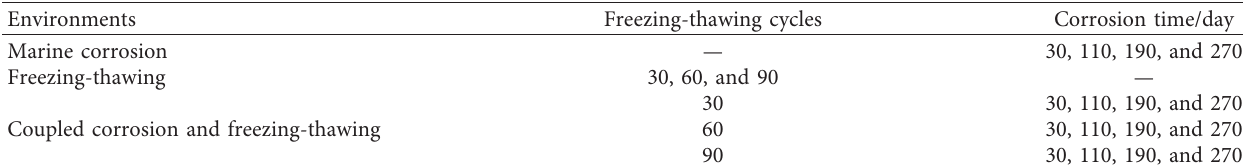
Table 2: The experimental scheme.